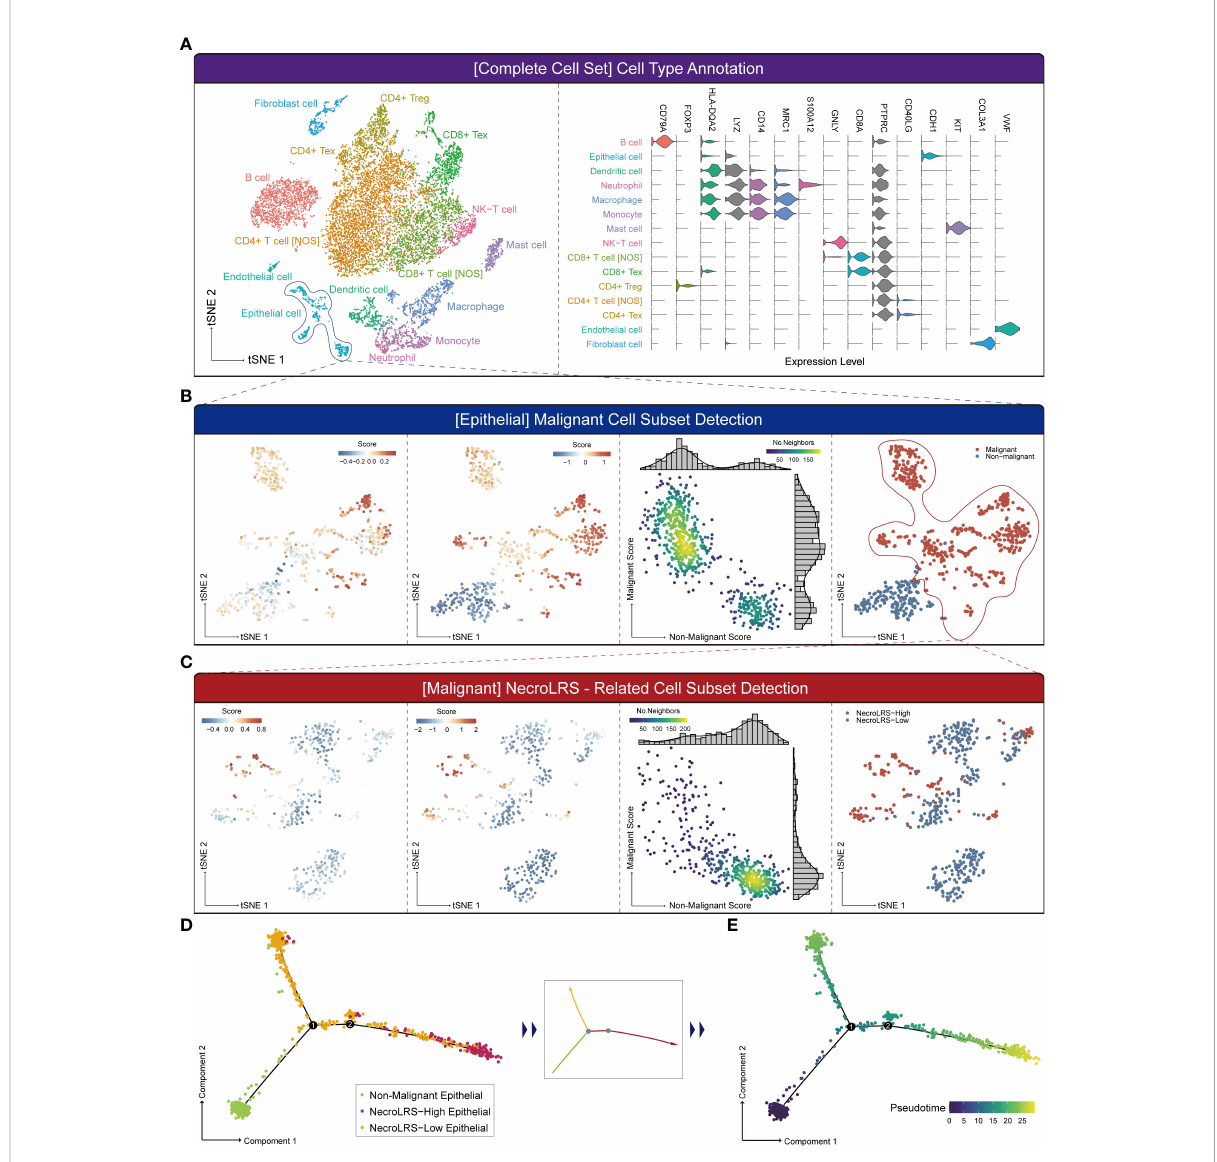
FIGURE 7 Single-cell RNA-seq-based NecroLRS-related subcluster exploration. (A) tSNE of the 13989 cells derived from 6 patients diagnosed with lung adenocarcinoma (left); based on cell type annotation complete cell sets are categorized into 15 cell subtypes, and representative markers of cell types are visualized using a violin plot (right). (B) Analysis of epithelial cell subset using malignant cell detection algorithm. The fi rst fi gure reveals the initial malignant score of each cell. Following iterations, the scores and markers across malignant and non-malignant cell subsets reached a plateau (second fi gure). The k-means distributions of both malignant and non-malignant scores were visualized via scatter plot (third fi gure). Each point corresponds to a cell and is color-coded to indicate the number of neighbors, which re fl ects the density. Finally, malignant and non- malignant cell subsets were obtained based on the malignant and non-malignant scores. (C) Analysis of malignant cell subset using NecroLRS- associated cell detection algorithm. Cell trajectory of epithelial cells, grouped according to NecroLRS-associated cell subsets (D) . Cell trajectory of epithelial cells, based on pseudo-time assumed in the condition of non-malignant epithelial subcluster as the root of trajectory (E)